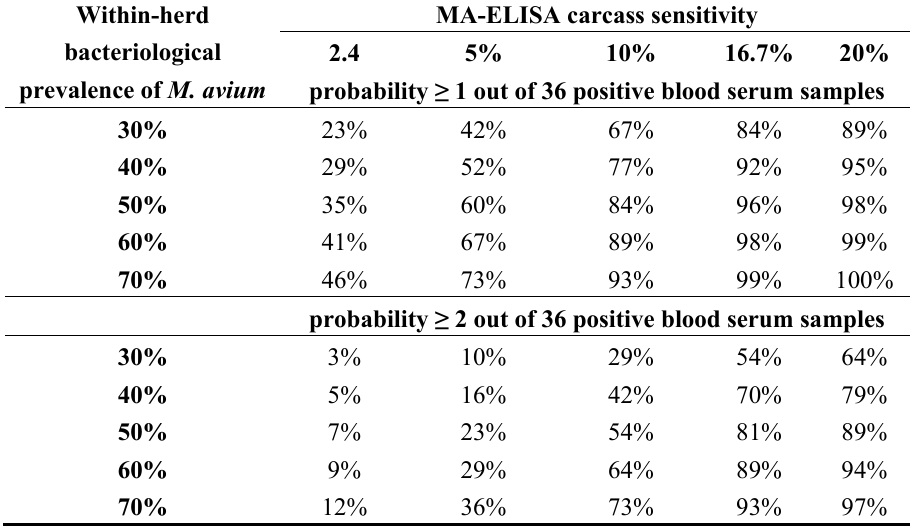
Table 3. Herd sensitivity of the MA-ELISA in a range of observed carcass sensitivities and bacteriological prevalences of M. avium at 1 or more and 2 or more positive samples for a positive herd